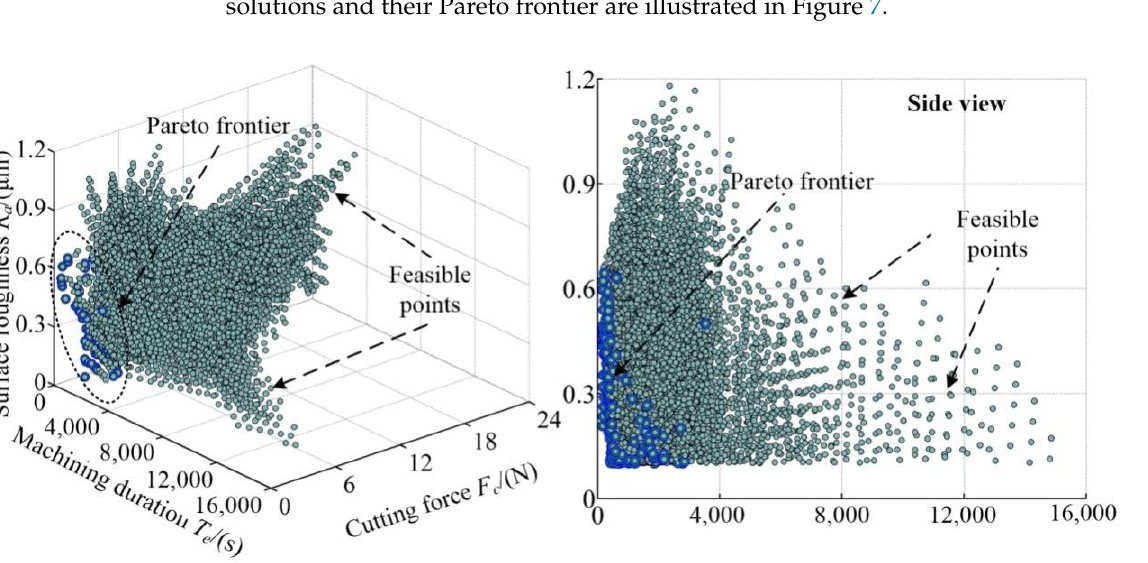
Table 6. Pareto solutions and corresponding cutting parameters.